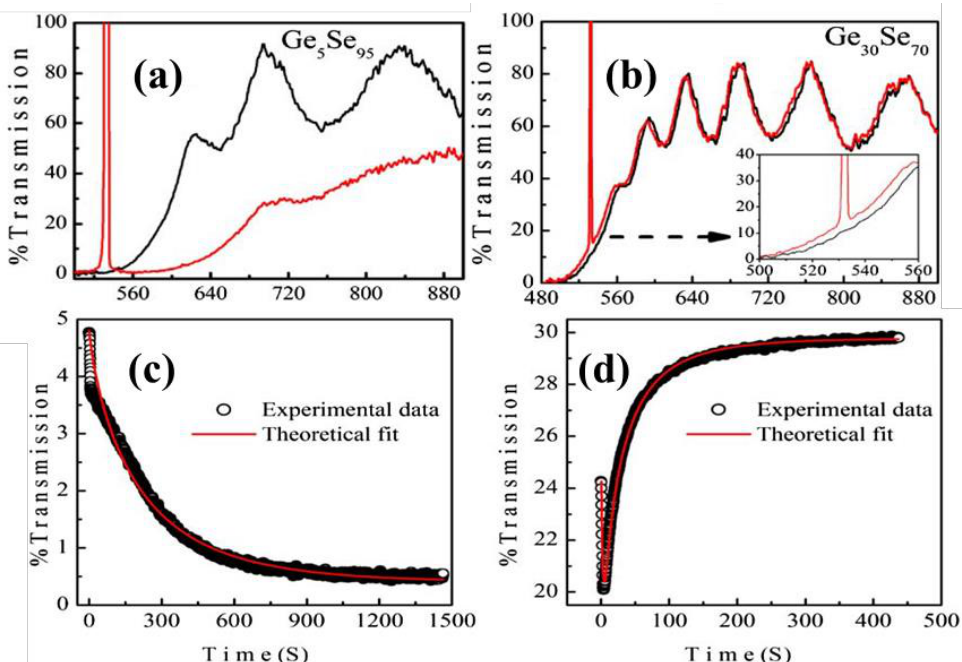
Figure 6. ( a ) Ge 5 Se 95 and ( b ) Ge 30 Se 70 thin films in as-prepared (solid black line) and illuminated (solid red line) states when excited with 532 nm laser. Single wavelength kinetics of T f / T i at 560 nm, when illuminated with 532 nm laser of intensity 0.5 W/ cm 2 for ( c ) Ge 5 Se 95 and ( d ) Ge 30 Se 70 . Here the hollow circles represent the experimental data, while the solid red line indicates theoretical fit.